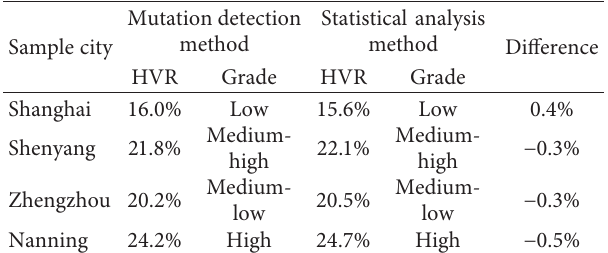
Figure 4: Distribution of HVR in different geographical regions. Table 4: Verification of HVR by different threshold extraction